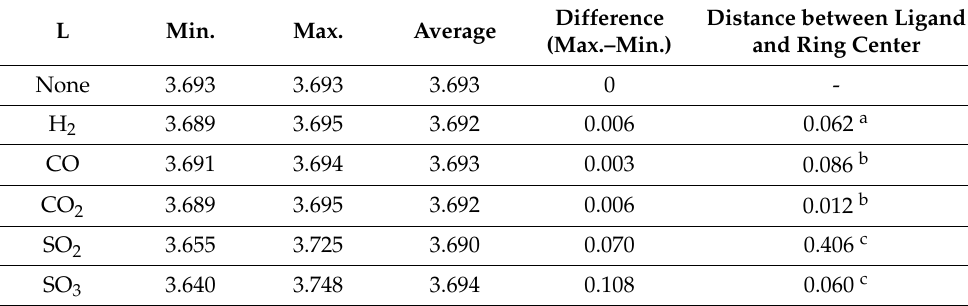
Difference Distance between Ligand (Max.–Min.) and Ring Center